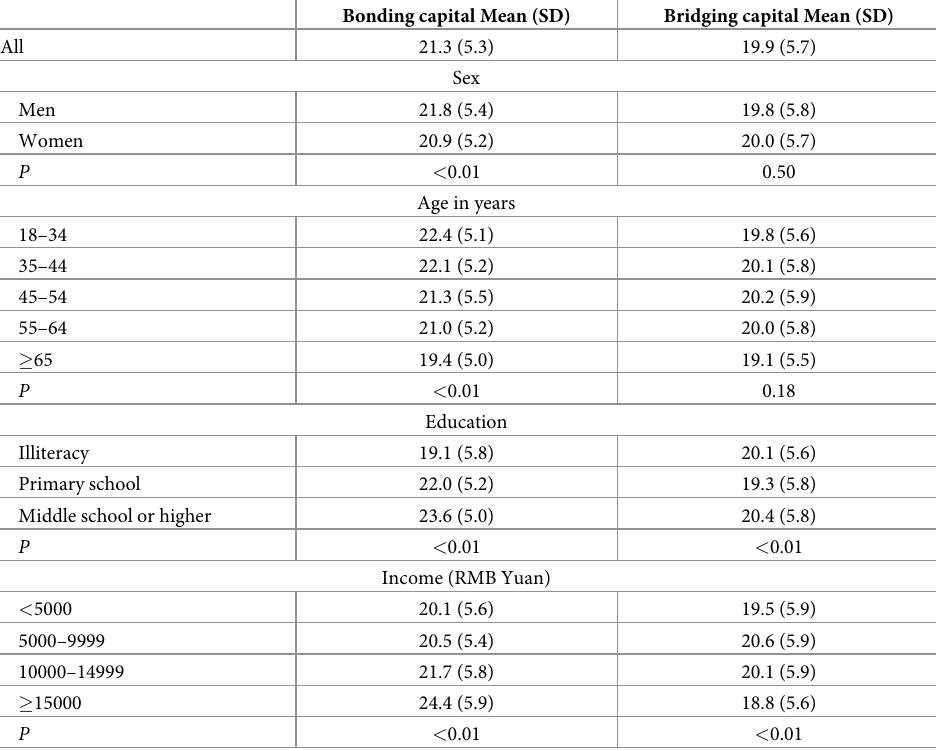
Table 3 shows the sociodemographic characteristics of the participants across quartiles of the dietary patterns. People with lower income ( < 10000 Yuan per year) were more likely to consume the traditional diets. In contrast, people who preferred the modern pattern were younger ( < 45 years), had higher educational levels (primary school or higher) and income ( � 10000 Yuan per year). Table 4 presents bonding and bridging social capital scores by sociodemographic character- istics. Mean scores of bonding and bridging social capital were 21.3 and 19.9, respectively. Table 4. Social capital scores by sociodemographic